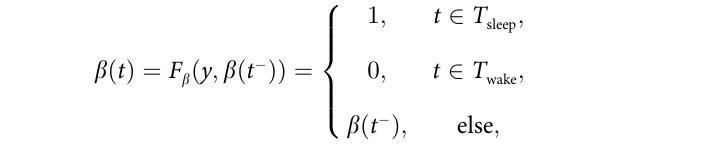
(red nodes) and falls asleep spontaneously when B = H m